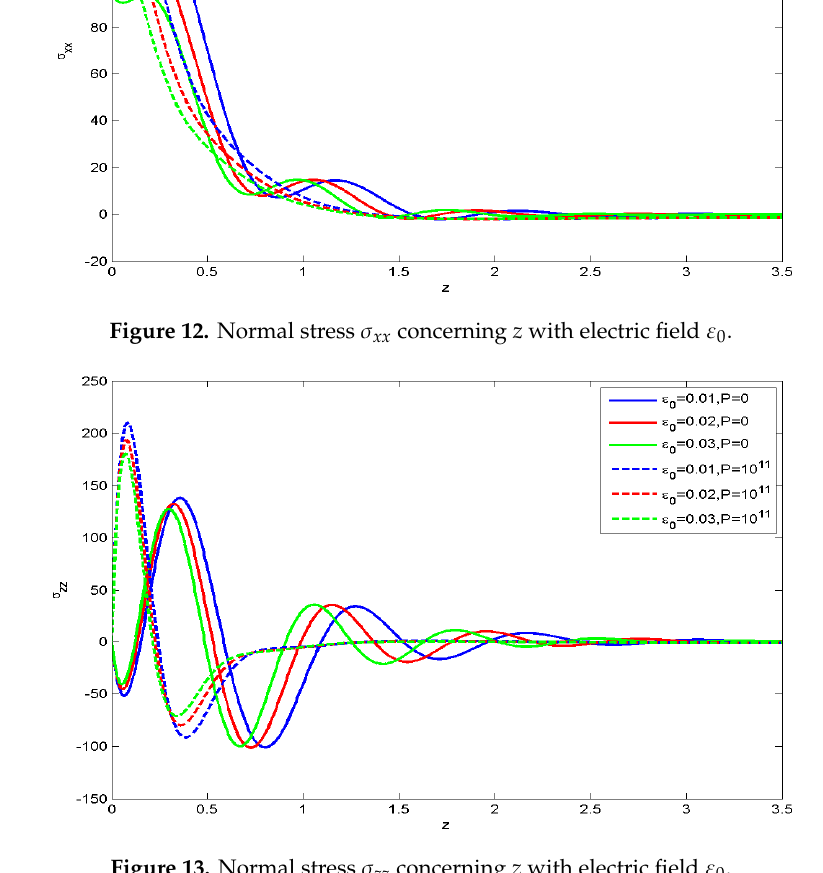
σ concerning z with electric field 0